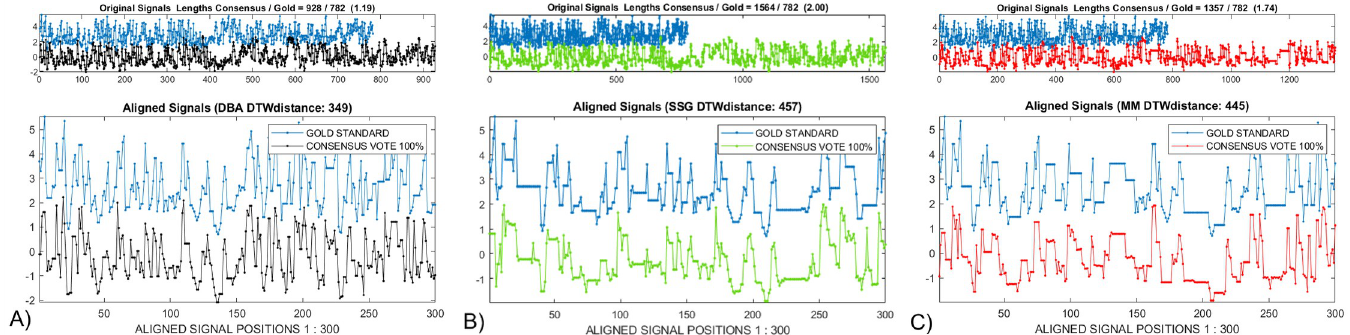
Fig 4. A modification of the image from the MATLAB dtw() program [20] is useful when empirically comparing the results from the DTWA algorithms for the Sequin R2-55-3 . Entries in the upper window are scaled so that the narrower white band in A) shows that the DBA DTWA produces a consensus, black, with a length closer to the gold standard than either the B) SSG , green, or C) MM , red, algorithms. The lower window displays a short, offset version of the aligned signals helping to illustrate the relative level of distortions between the DTWA consensuses: B) High for SSG DTWA , C) medium for MM with A) only the DBA consensus signal remaining 20% longer than the gold signal providing an obvious indication of hidden